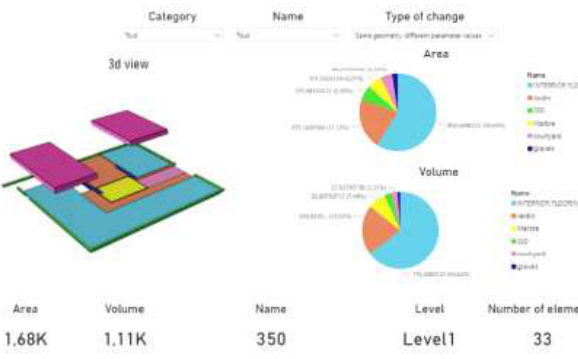
Figure 10. Change detection